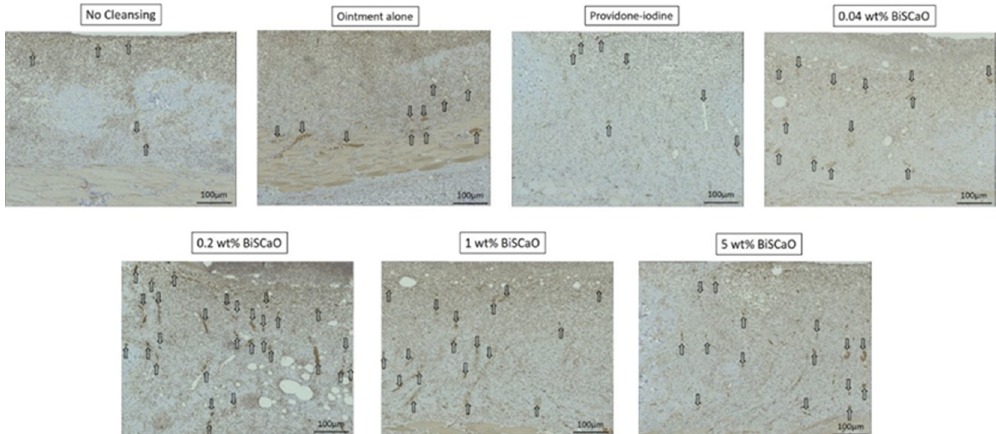
Figure 6. Histological examination of capillary formation with CD-34-stained immunophotographs in each treatment group. The skin surrounding the infected wounds in each treatment group on Day 9 was harvested, processed for CD 34-staining, and microphotographed ( n = 6) (magnification: 200×). The arrows show blood vessels. The microphotographs represent the wounds for the indicated treatment group. Analysis of these microphotographs provides confirmation of the data given in Table 1.